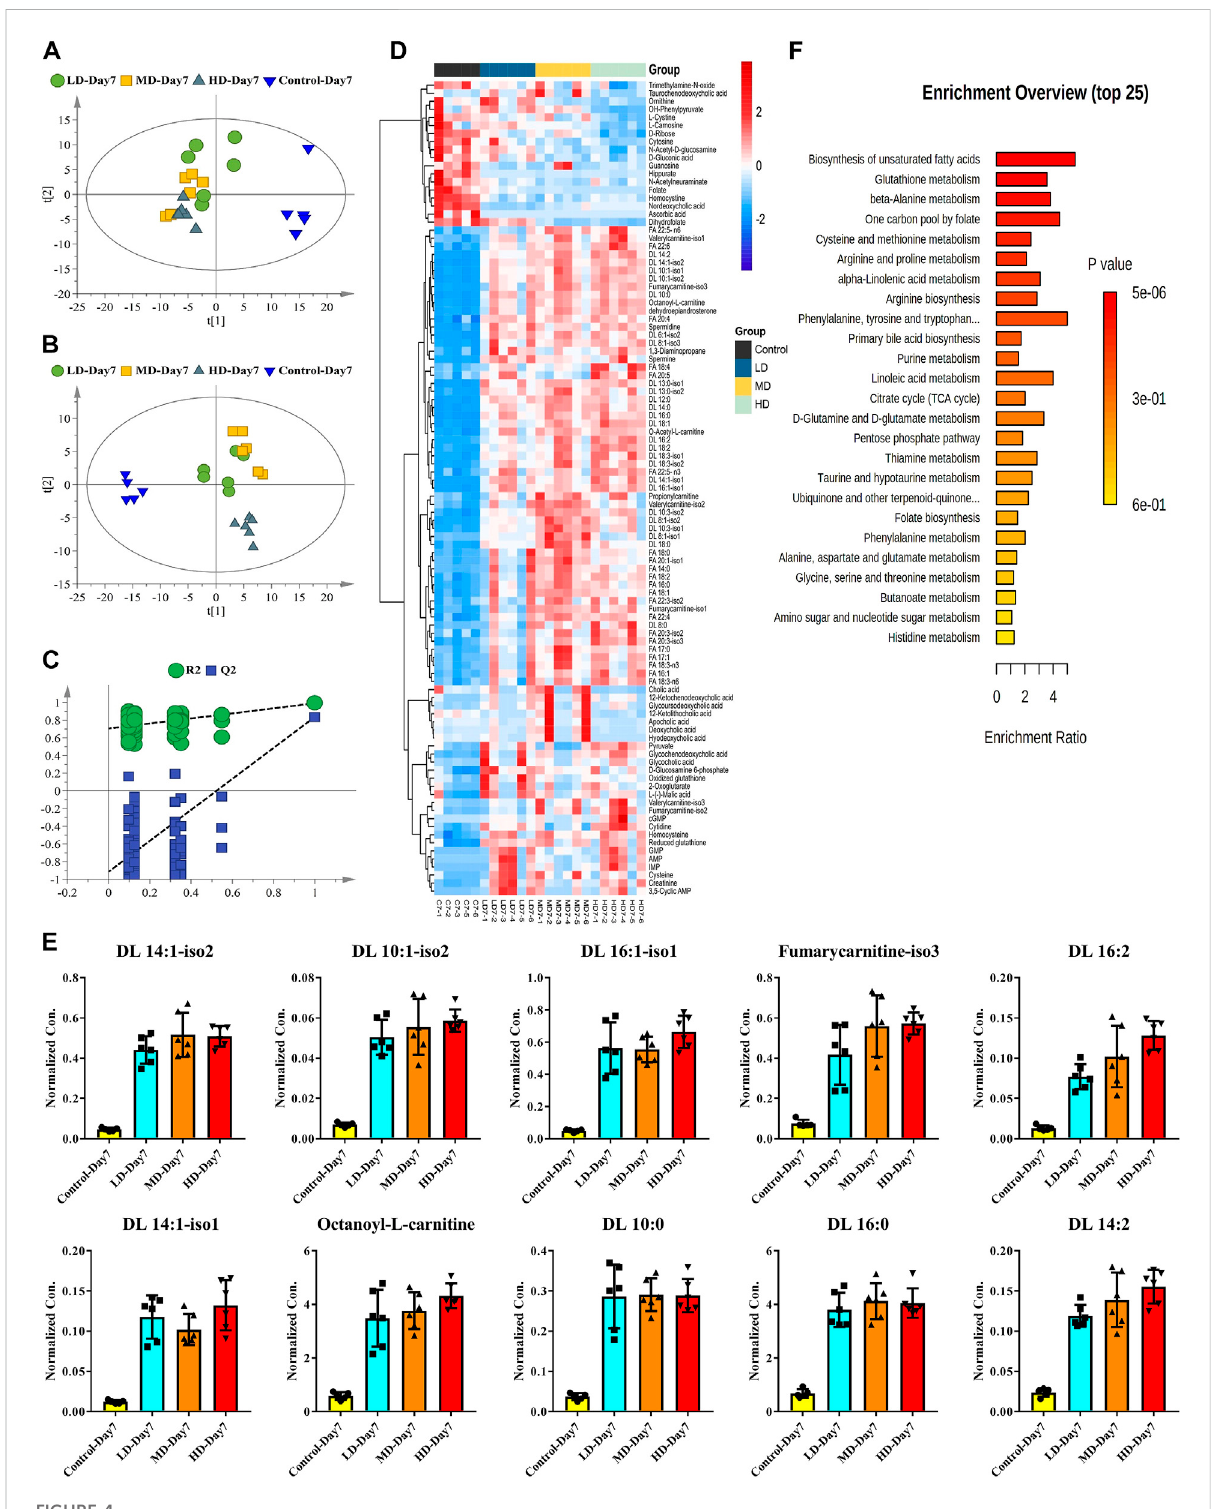
Dose-dependent manners of moxi fl oxacin related hepatotoxicity investigated by using the targeted metabolomics data of the 7-day administration groups. (A) PCA score scatter plot. (B) PLS-DA score scatter plot. (C) Random permutation test of the PLS-DA model. (D) Heatmap of the signi fi cantly changed metabolites between control group and 7-day HD group. (E) Dose-dependent manners of the top 10 fatty acyl carnitines with the most signi fi cant changes between the control group and the HD group. (F) Metabolic pathways associated with moxi fl oxacin related